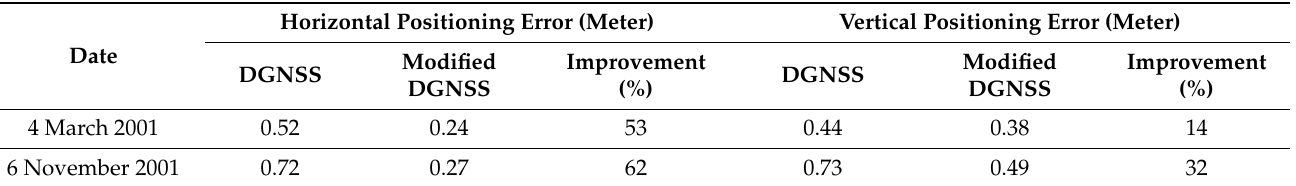
Table 2. Improvements in DGNSS positioning error by using network RTK corrections.